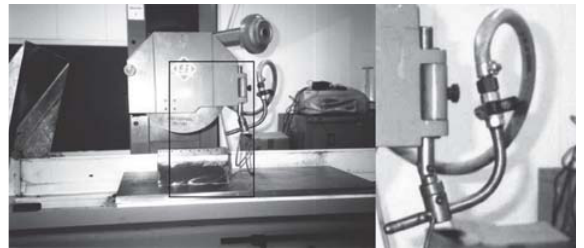
Figure 4. Comparative results for the average